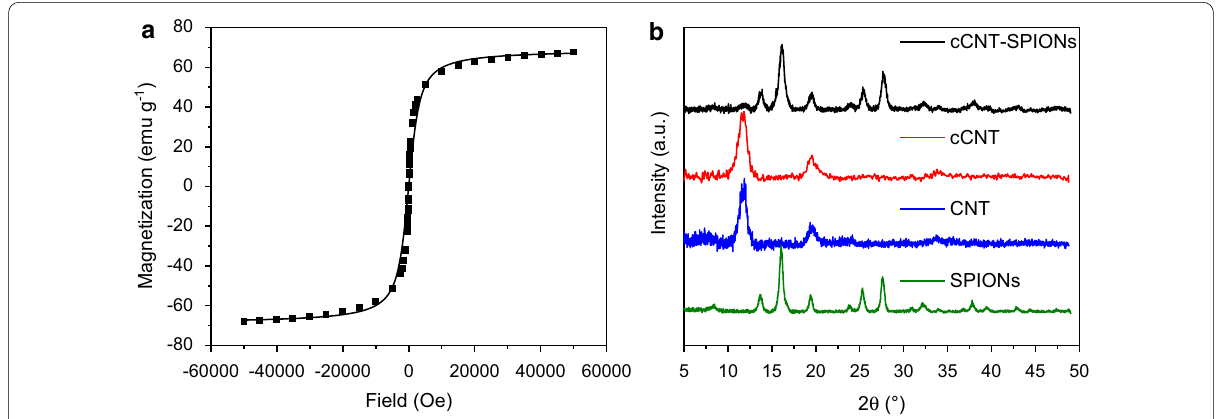
Fig. 2 Magnetic hysteresis curve obtained with a SQUID from ‑50,000 to 50,000 Oe at 300 K ( a ) and powder XRD patterns of cCNT‑SPIONs, cCNTs, CNTs and SPIONs obtained with a MoKα source ( b )